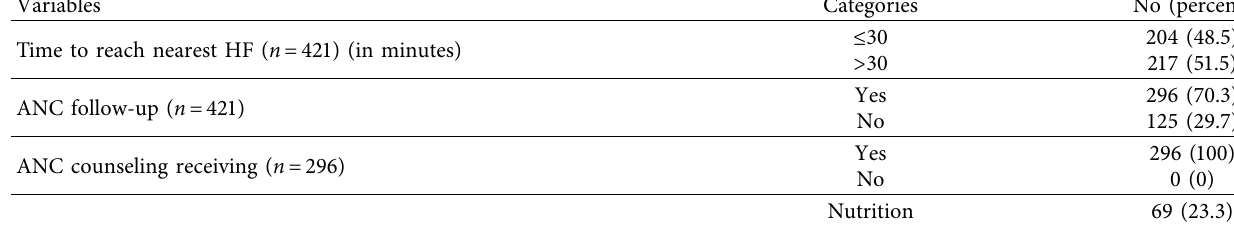
Table 3: Healthcare service utilization of mothers in Anlemo district, southern Ethiopia, 2019. Variables